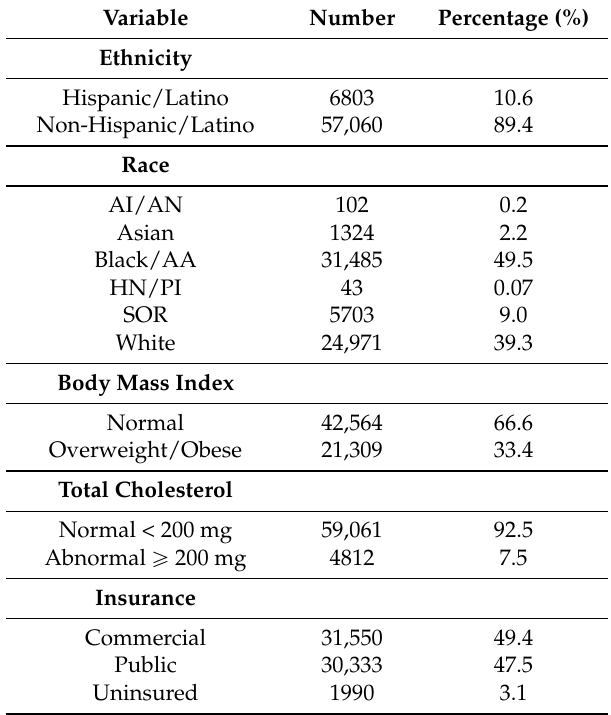
Table 1. Study sample